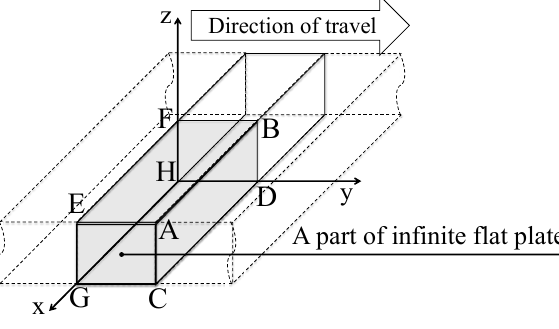
Figure 2. Ceramic thin sheet traveling in a dryer.